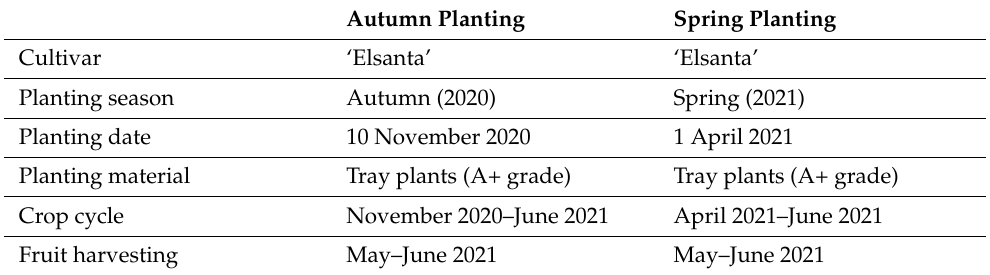
Table 1. The experimental details.